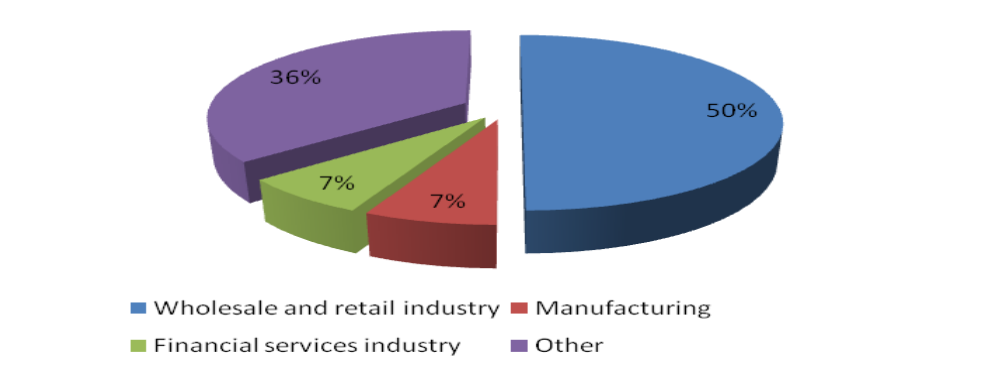
Figure 7: Respondents by industry